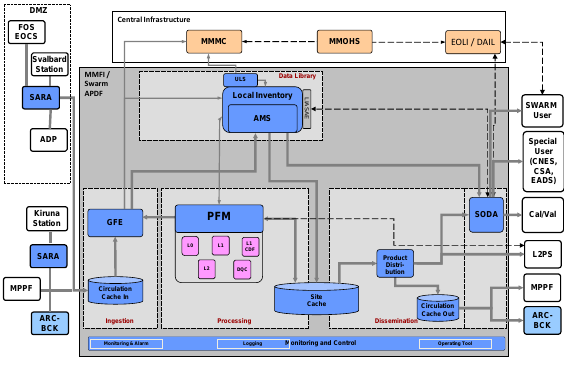
Figure 2: Swarm APDF Architecture and Context